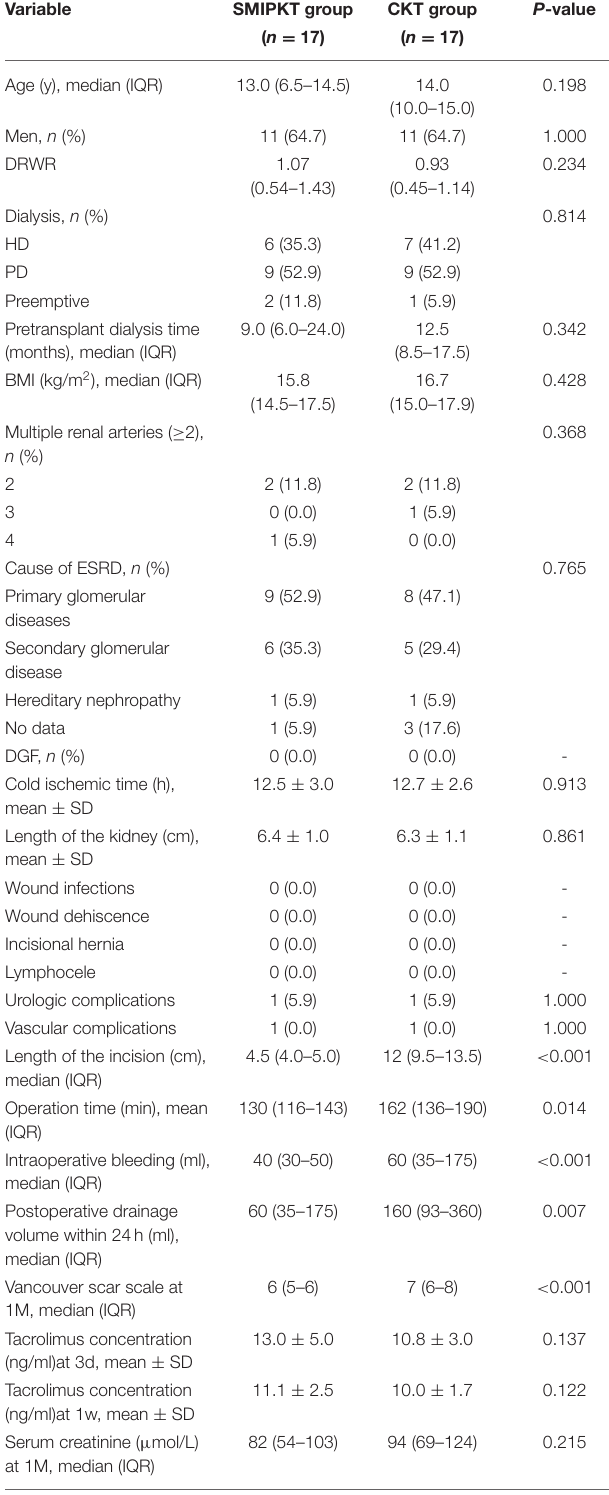
TABLE 1 | Characteristics of